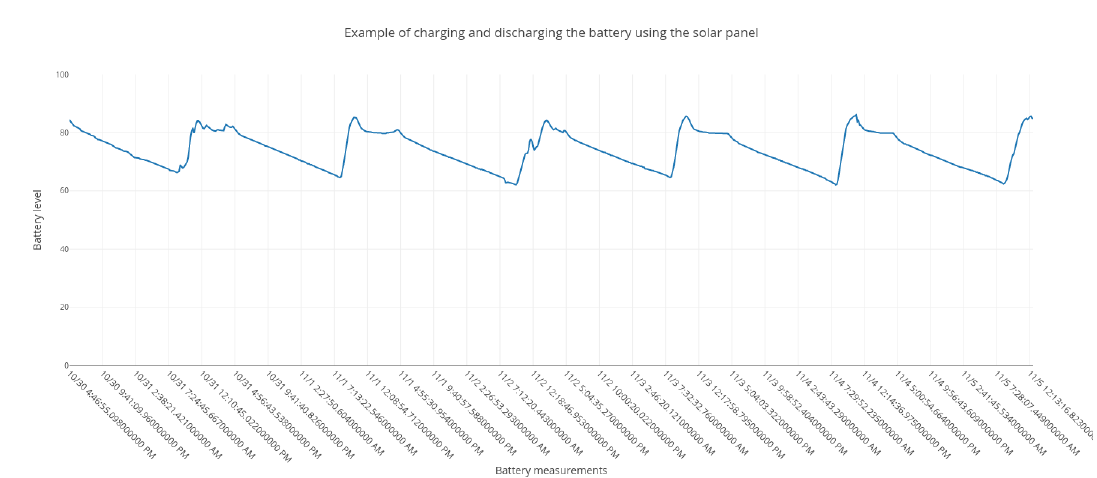
Figure 10. Example of charging and discharging the battery using the solar